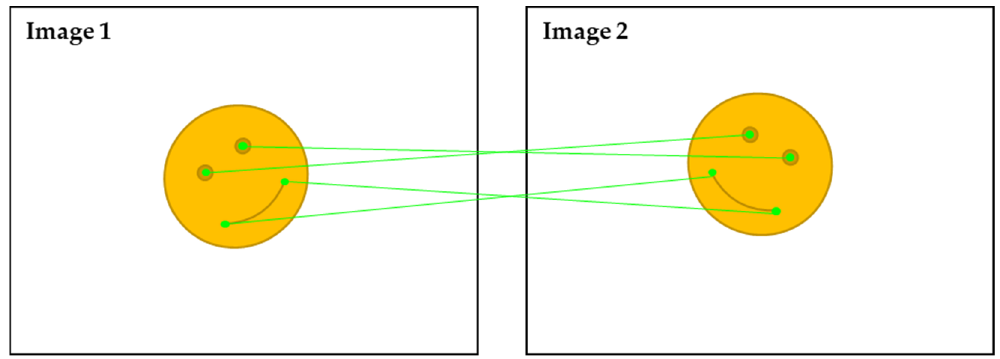
Figure 4. Feature matching.